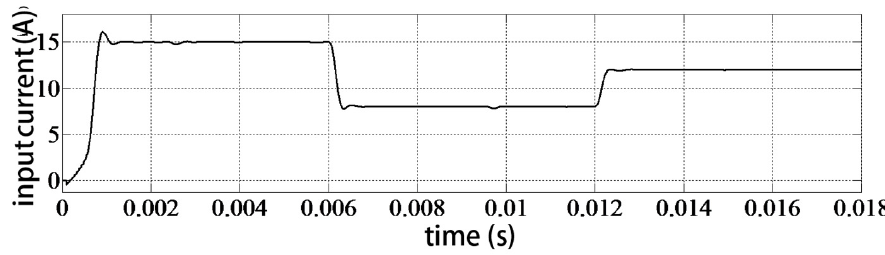
Figure 10. Fuzzy-control-based load simulation strategy variable load Simulink simulation results.